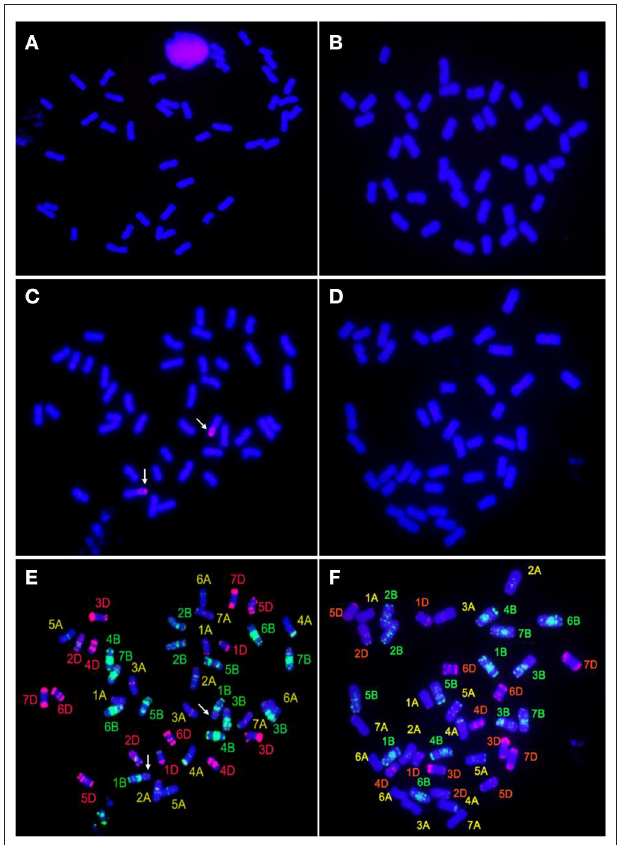
FIGURE 3 | GISH-FISH analyses of SN0293-2 and SN0293-7. (A) GISH patterns of SN0293-2 probed with total genomic DNA of Thinopyrum ponticum . (B) GISH patterns of SN0293-7 probed with total genomic DNA of Th. ponticum . (C) GISH patterns of SN0293-2 probed with total genomic DNA of rye. (D) GISH patterns of SN0293-7 probed with total genomic DNA of rye. (E) FISH patterns of SN0293-2. (F) FISH patterns of SN0293-7. Arrows indicate the translocation T1BL ·